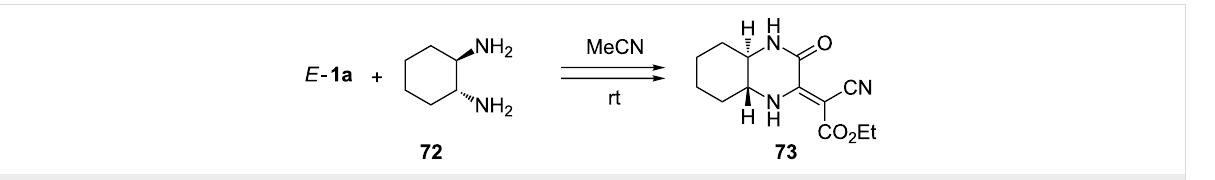
Scheme 22: Reactions of aryl- and hetarylcarbohydrazides 67 with E - 1a .